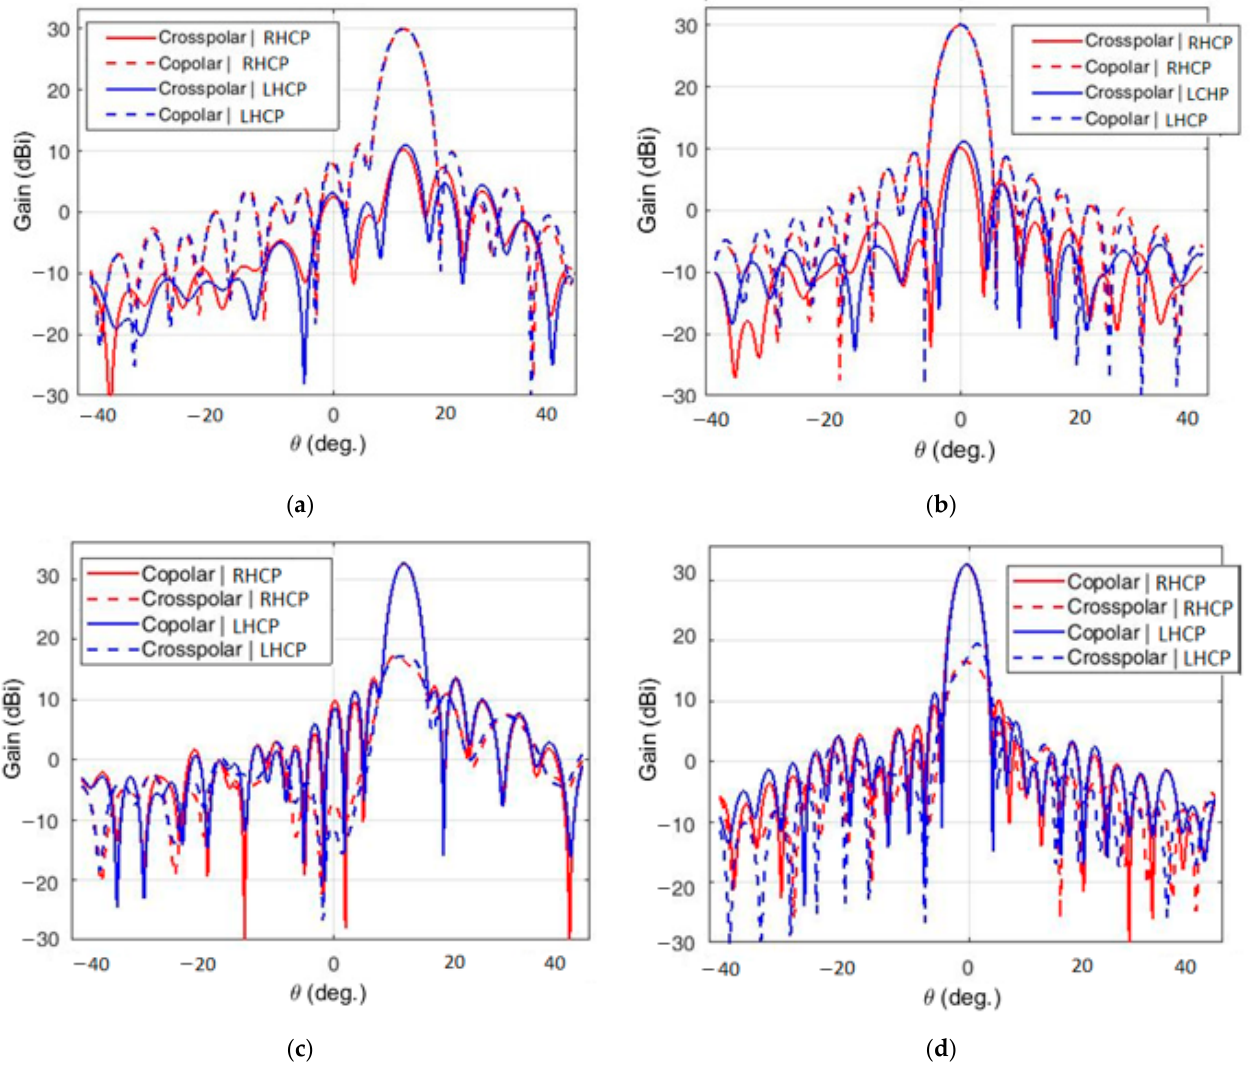
Figure 16. Simulated radiation patterns: at 19.7 GHz ( a ) in the xz -plane and ( b ) in the azimuth plane, and 29.5 GHz ( c ) in the xz -plane, and ( d ) in the azimuth plane.